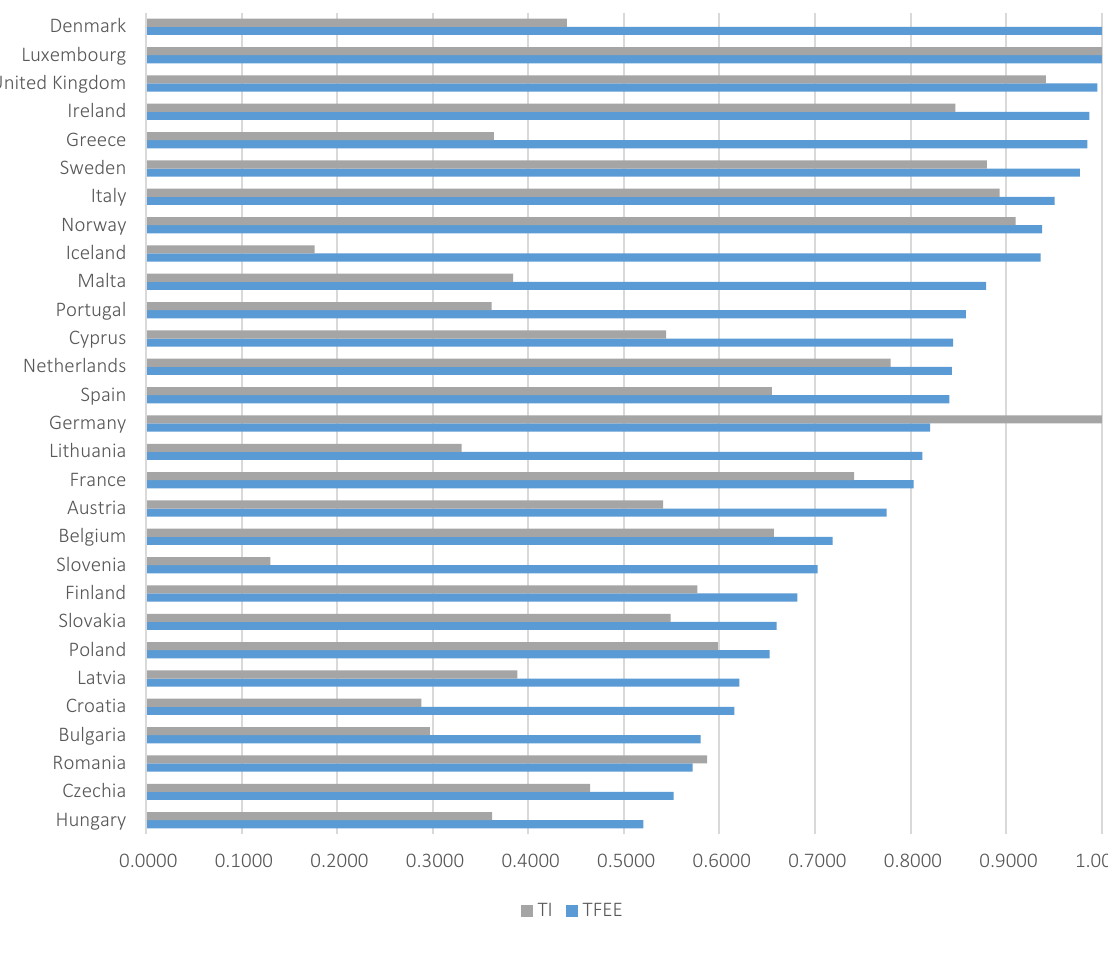
Figure 7. Average values of TFEE and TI, 2012–2020